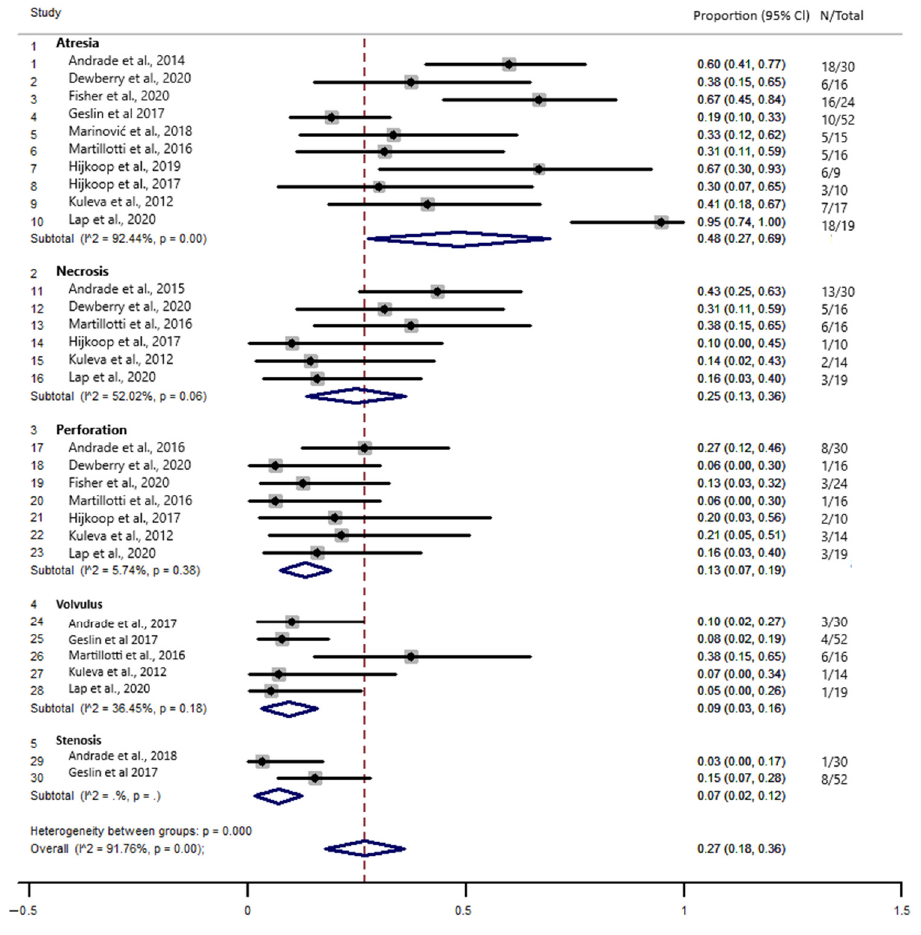
Figure 3. Forest plot of the combined prevalence of atresia, necrosis, perforation, volvulus, and stenosis in fetal complex